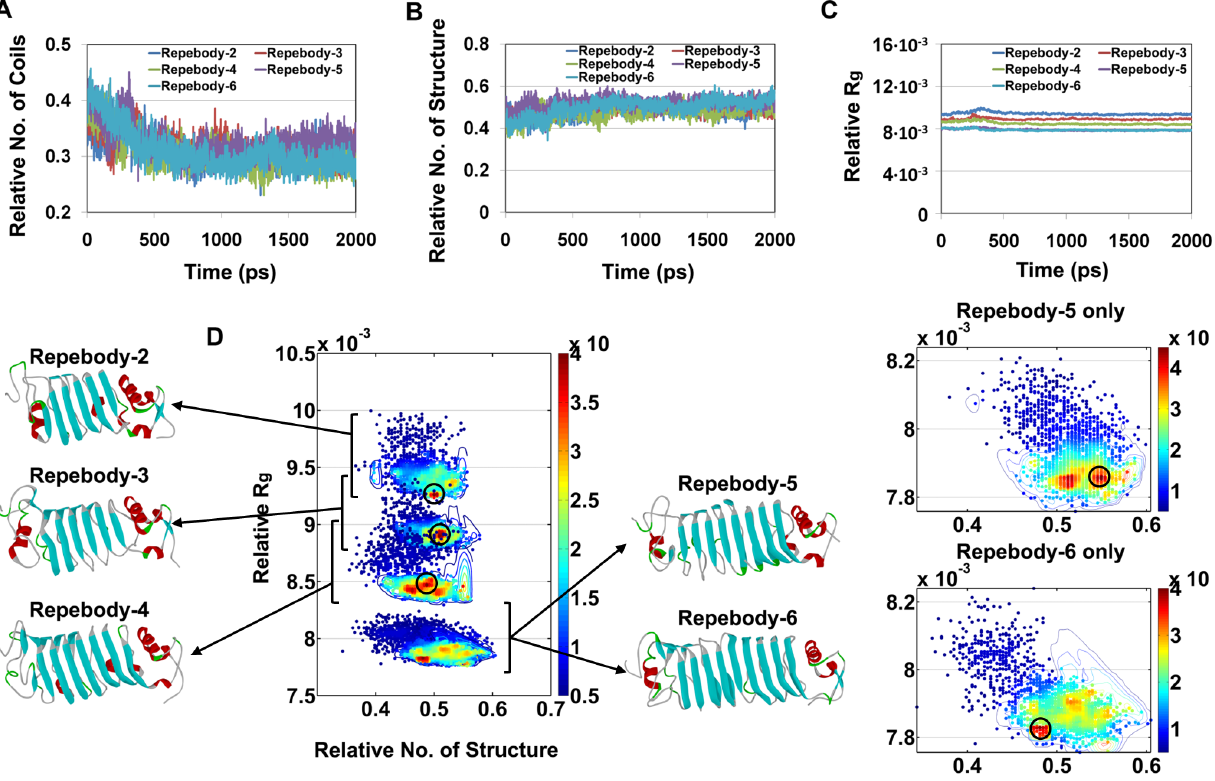
Figure 3. Comparison of structural properties in all the repebody ensembles. Time dependent changes of the secondary structures with relative number of coils (A) and structure (B). (C) Time dependence of the relative gyration ( R g) for the protein atoms during the simulation time. (D) Contour map of the probability density of relative R g as a function of relative number of structure. The most populated conformation for each repebody is highlighted by circle on the map and displayed by ribbon representations. Overlapped region of repebody-5 and 6 in the bottom of the map is separated and displayed into right panel.